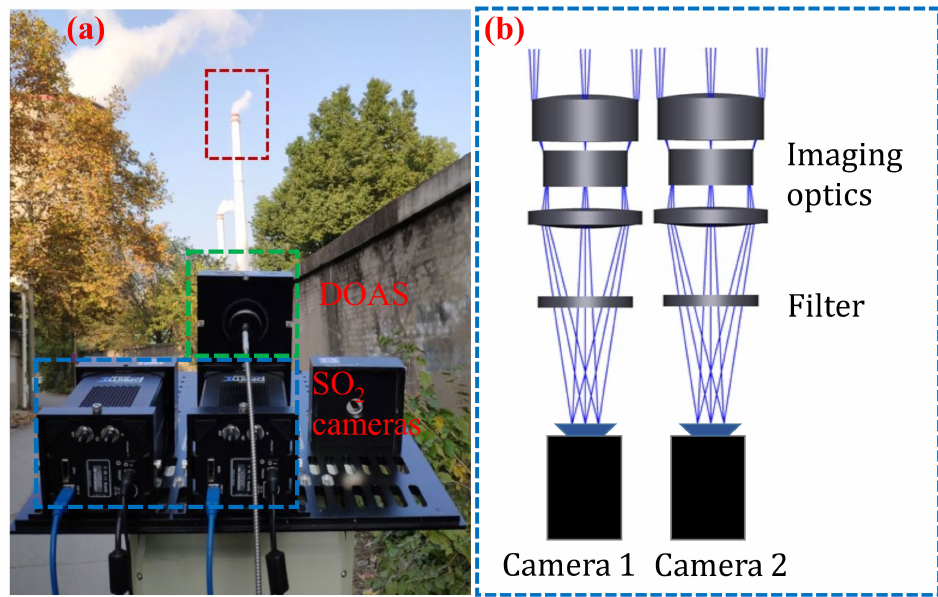
Figure 3. ( a ) Photograph of the SO 2 cameras system and differential optical absorption spectroscopy (DOAS) system; ( b ) The optical diagram of the SO 2 camera